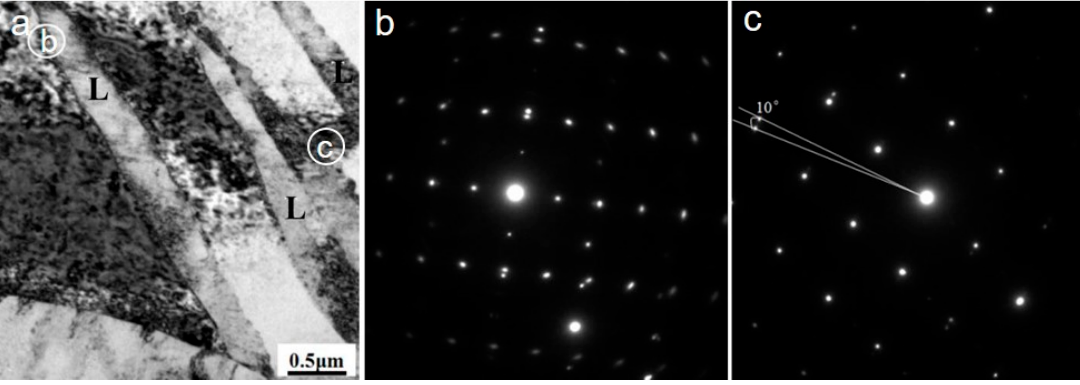
Figure 3. Transmission electron microscopy images of sample F-12. ( a ) bright field imagee; ( b ) selected oodiffraction pattern of a micro shear band.